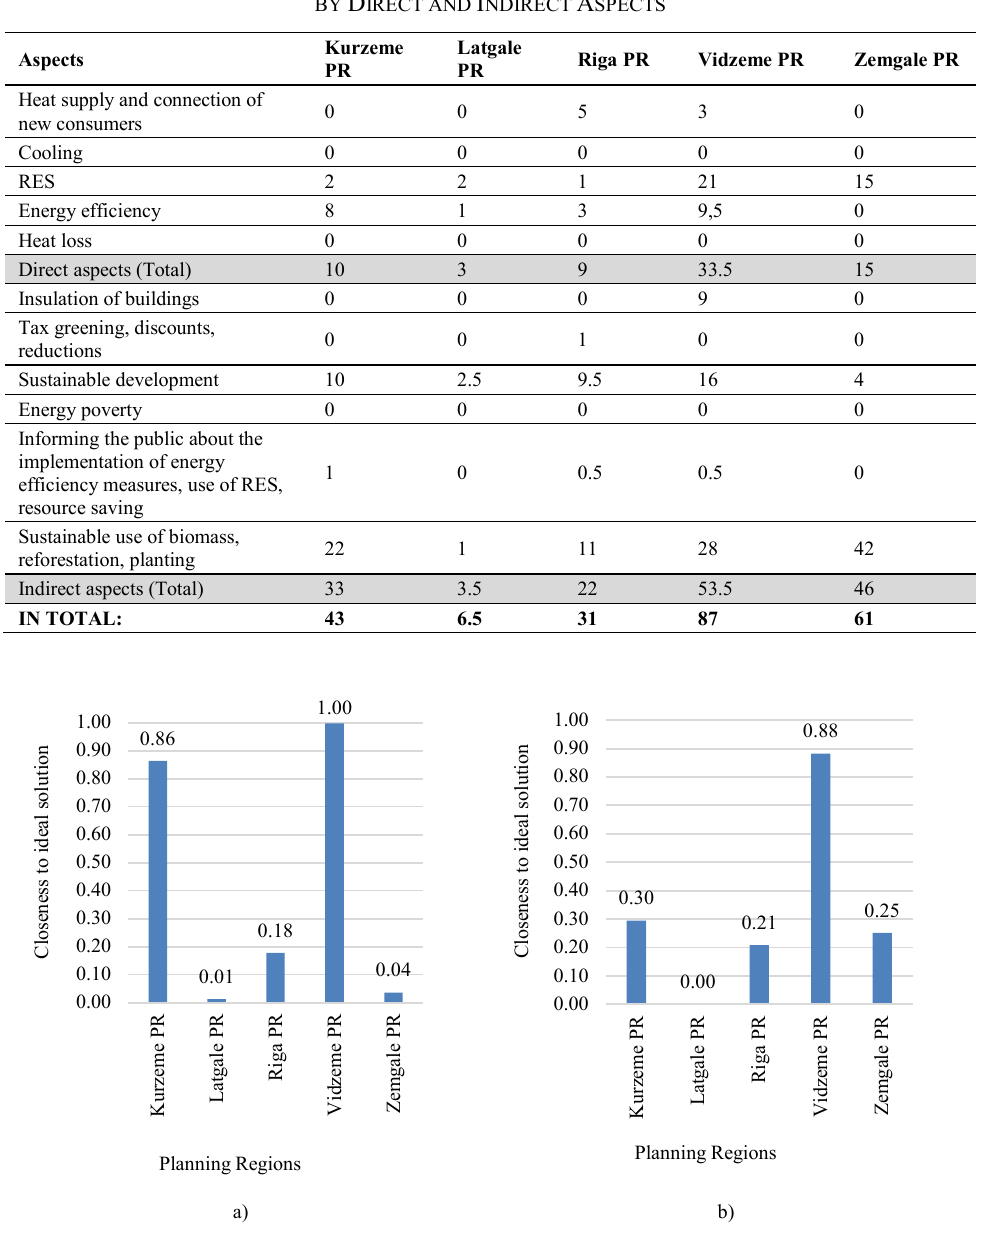
Fig. 2. TOPSIS and AHP evaluation results of a) direct aspects and b) indirect aspects for planning